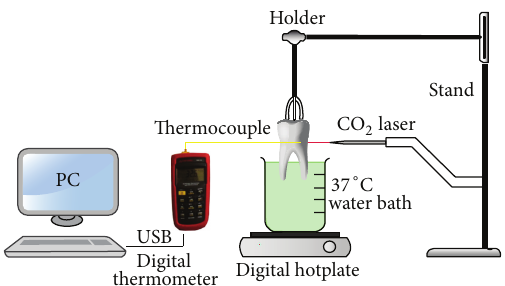
Figure 2: Experimental setup for temperature